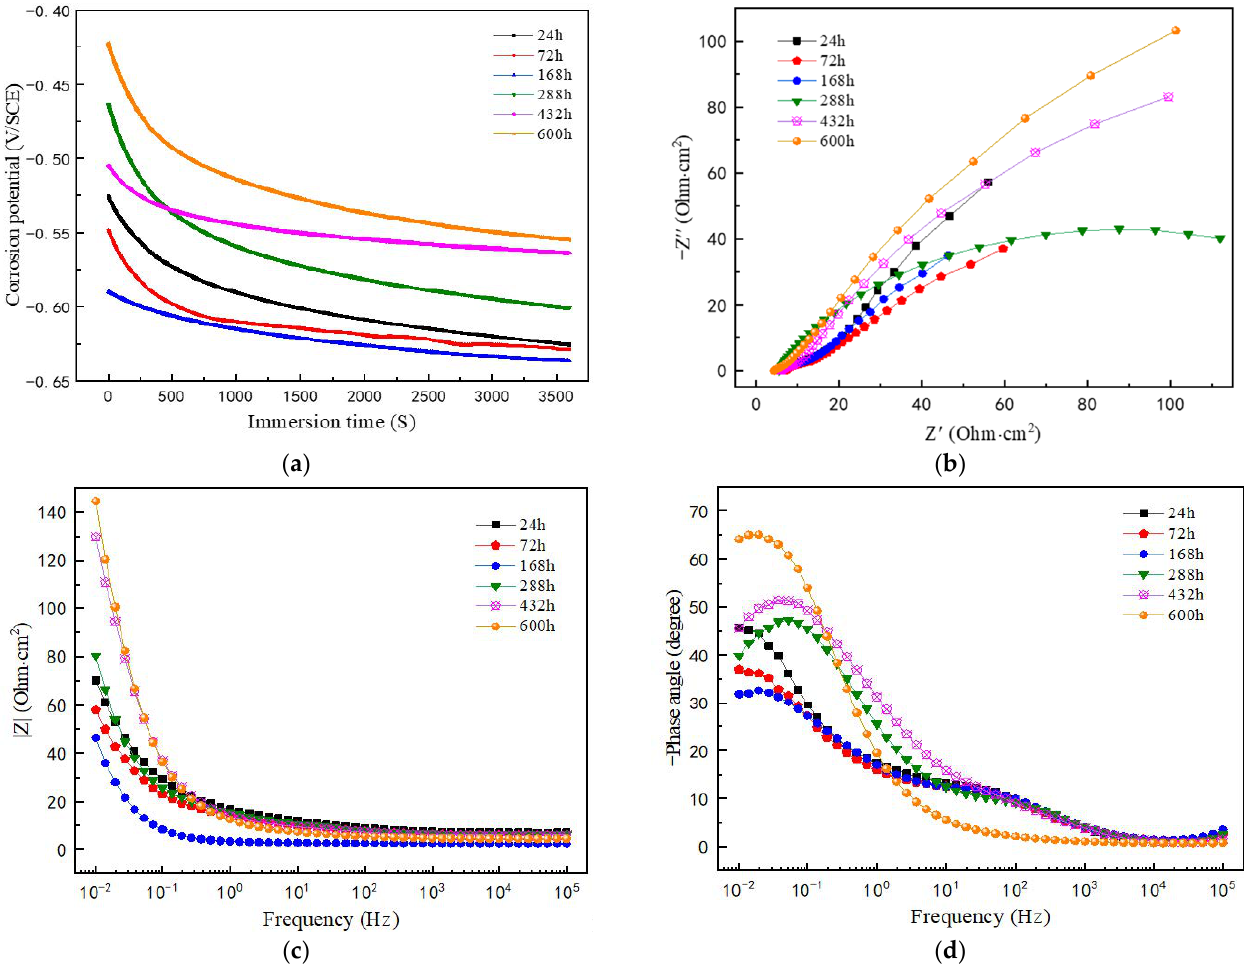
Figure 11. Nyquist and Bode plots of medium-Mn steel in simulated seawater medium after corrosion at different times: ( a ) OCP for 1 h; ( b ) Nyquist plot; ( c ) impedance mode vs. frequency plot; ( d ) phase angle vs. frequency plot.